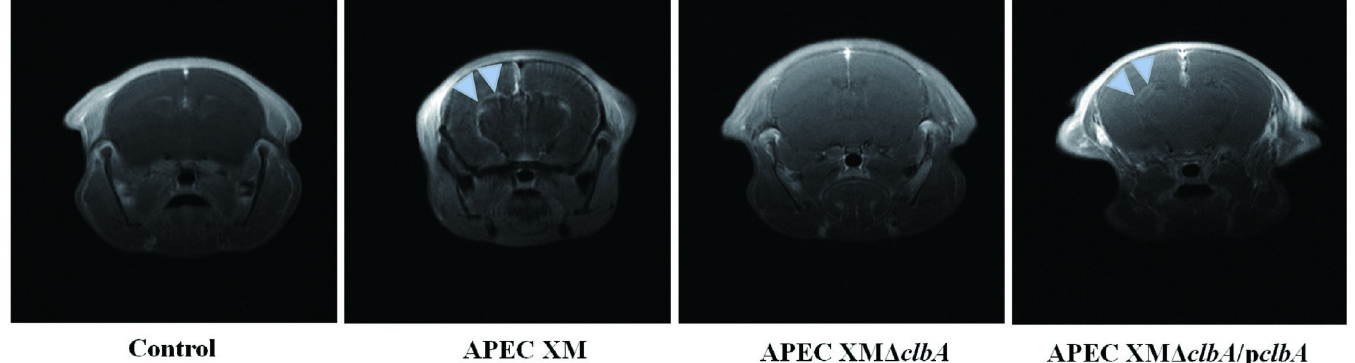
Fig 7. Lesion examination of mouse brains by MRI scanning. MRI was performed to assess the brain lesions at 12 h post infection. Diffusion enhancement of the cerebral parenchyma (Blue Arrowhead) are observed in the mice infected with APEC XM or APEC XM Δ clbA /p clbA .